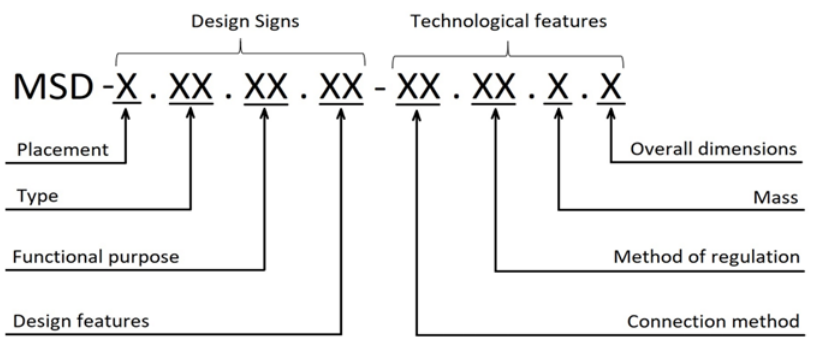
Figure 4. Design-and-technological classification of modular separation